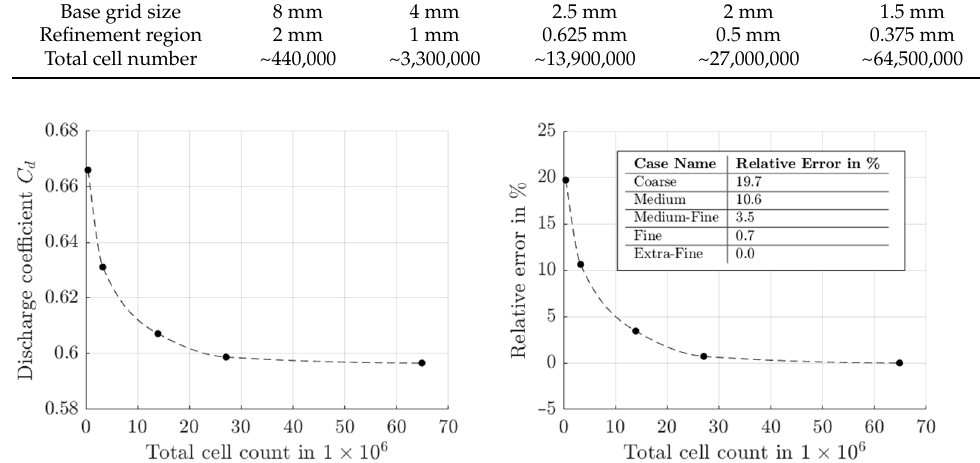
Figure 8. Discharge coefficient in dependence of grid size/total cell count ( left ). Relative error of discharge coefficient in dependence of total cell count ( right ).